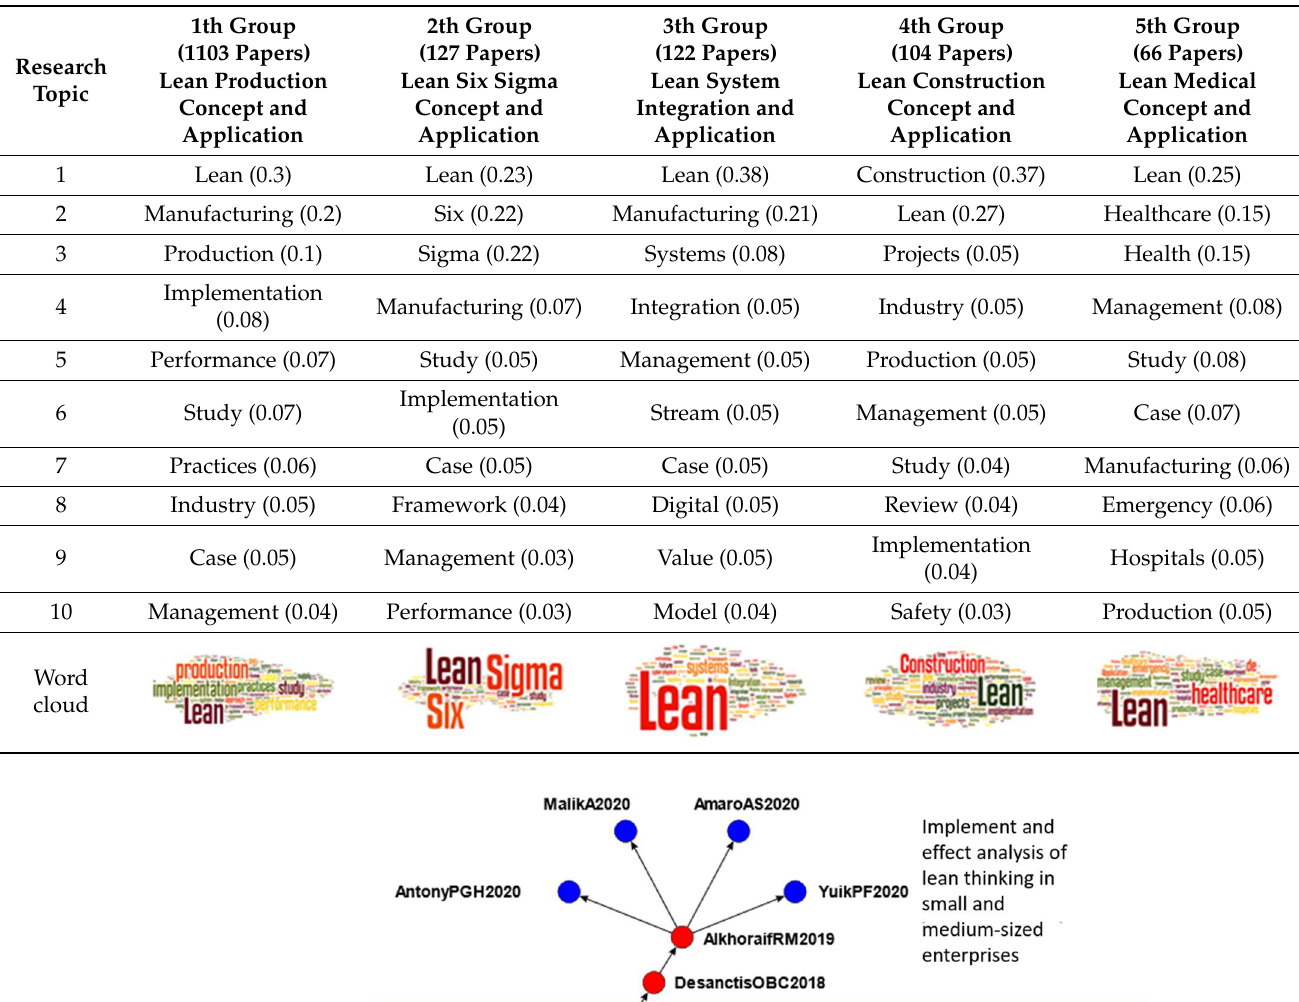
Table 1. The relevant information of the five groups.